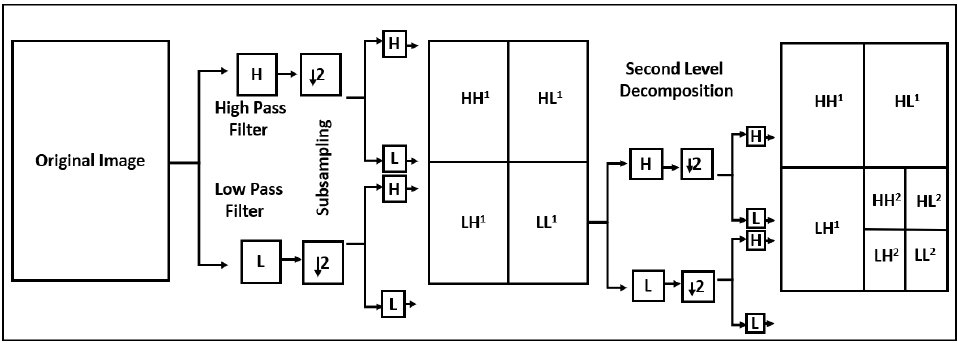
Figure 5. Two-level wavelet decomposition structure (recursive filtering and